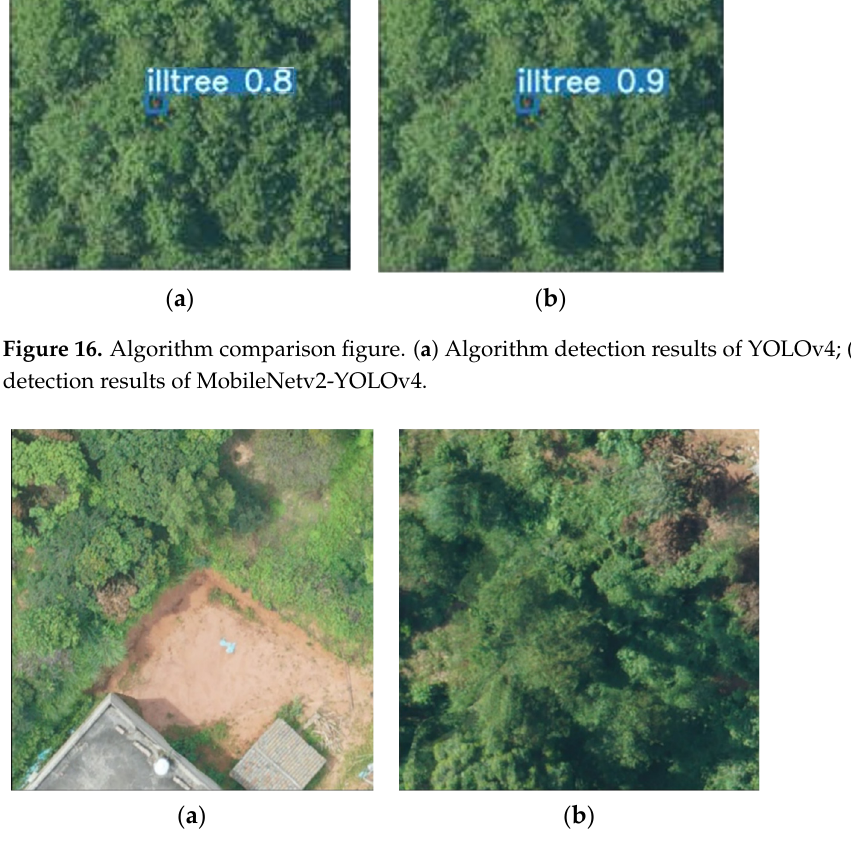
Figure 16. Algorithm comparison figure. ( a ) Algorithm detection results of YOLOv4; ( b ) Algo- rithm detection results of MobileNetv2-YOLOv4.